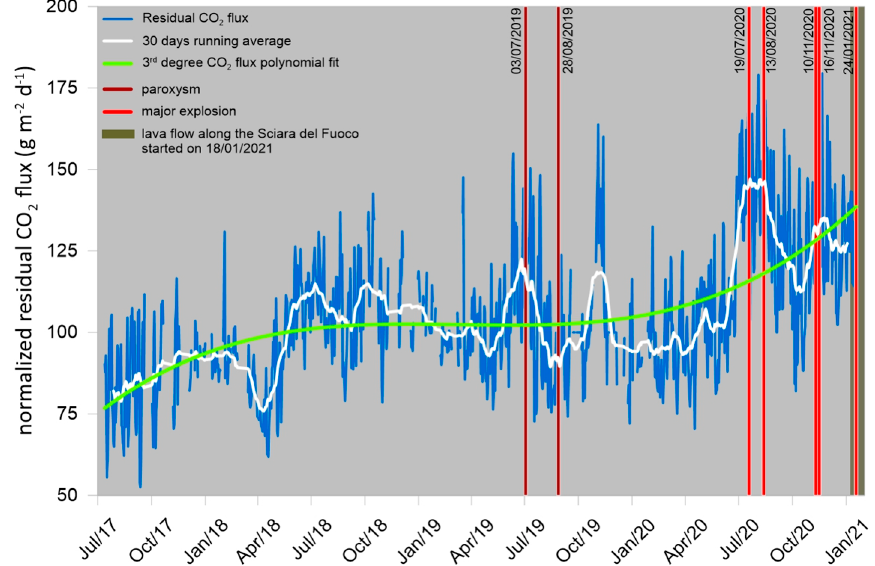
Figure 8. Daily average CO 2 fluxes (residuals) filtered and normalized to the average temperature (25 °C) of the 2017–2021 period. The 30 day running average (white line) and the 3rd degree polynomial fit (green line) have been plotted. The main events of volcanic activity (major explosions, paroxysm, and lava flow) have been reported too.